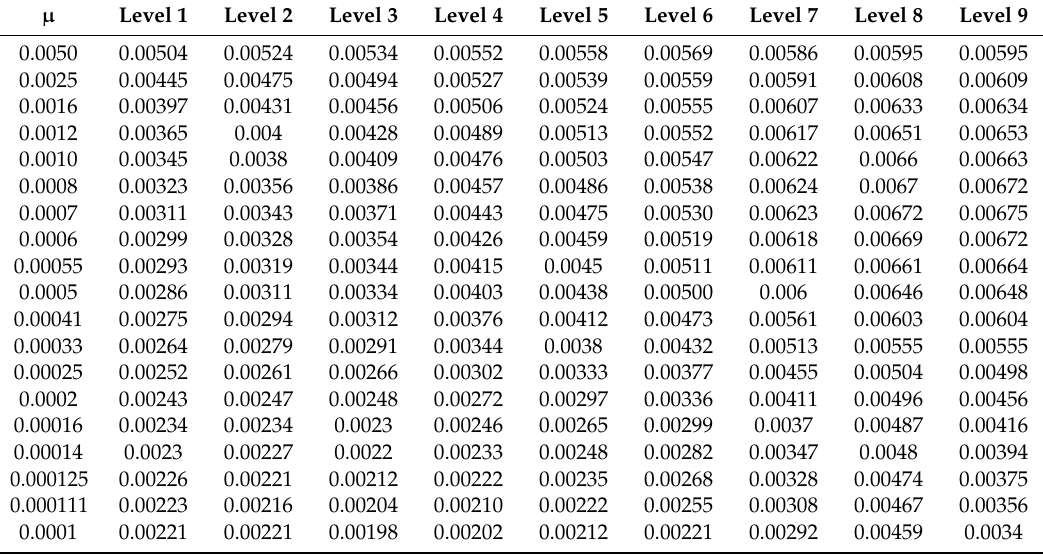
Table 4. Kinetic energy values when upper and lower walls are moving